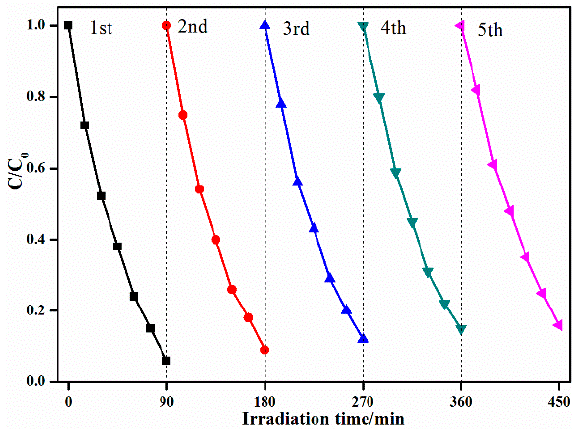
Figure 9. Stability investigation of MB photocatalytic degradation over Cu 2 O/ZnWO 4.